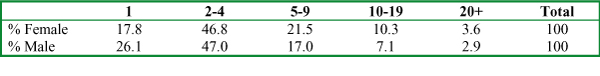
Number of times primary care provider was seen in previous 12 months, by sex. Statistics Canada, National Population Health Survey, 1998-99.